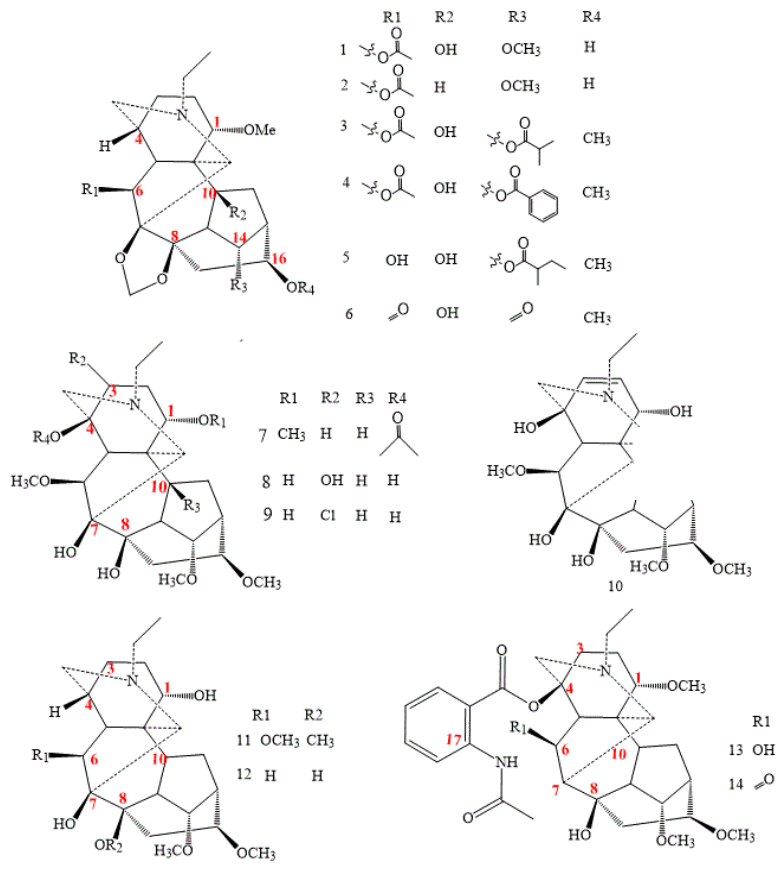
Figure 1. C 18 -ranaconitine Das.